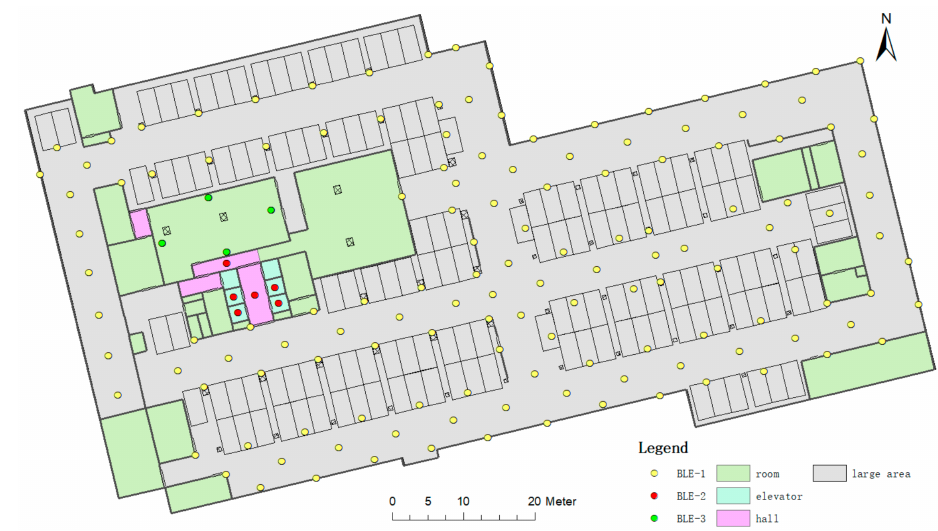
Figure 3. Physical area